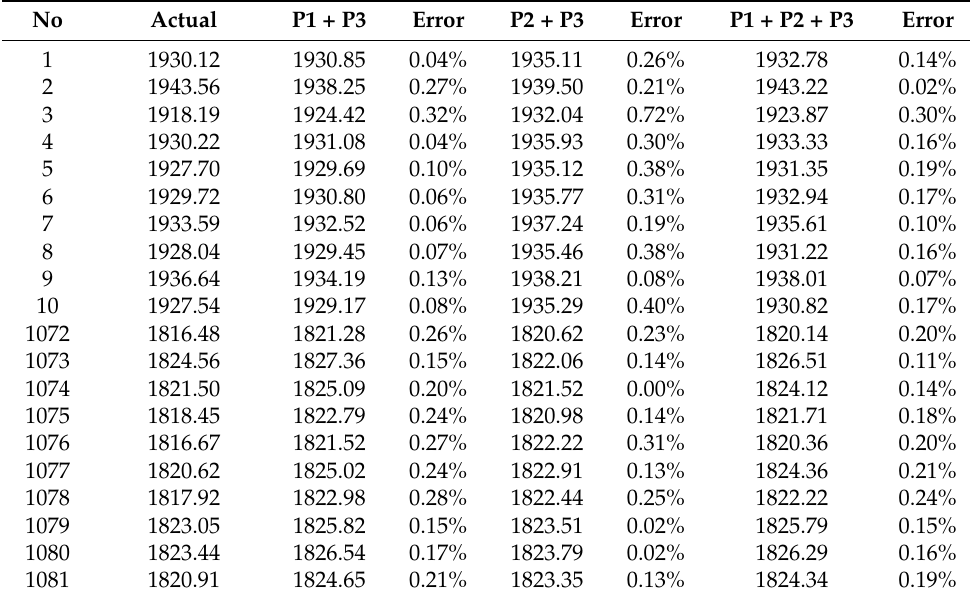
Table 4. Test data for P1 + P3, P2 + P3 and P1 + P2 +